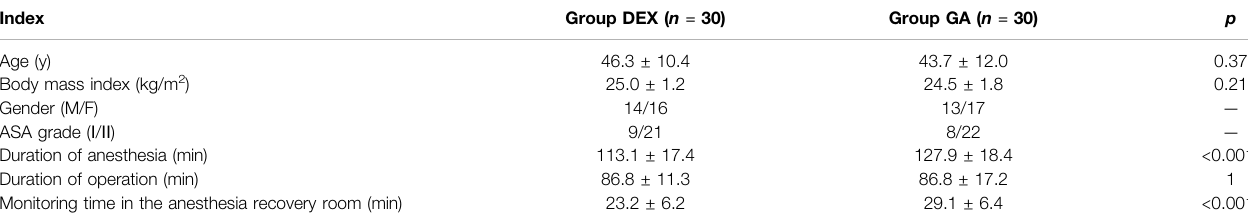
TABLE 1 | Analysis of the general characteristics and the perioperative indexes [ n or (Mean ± SD)].